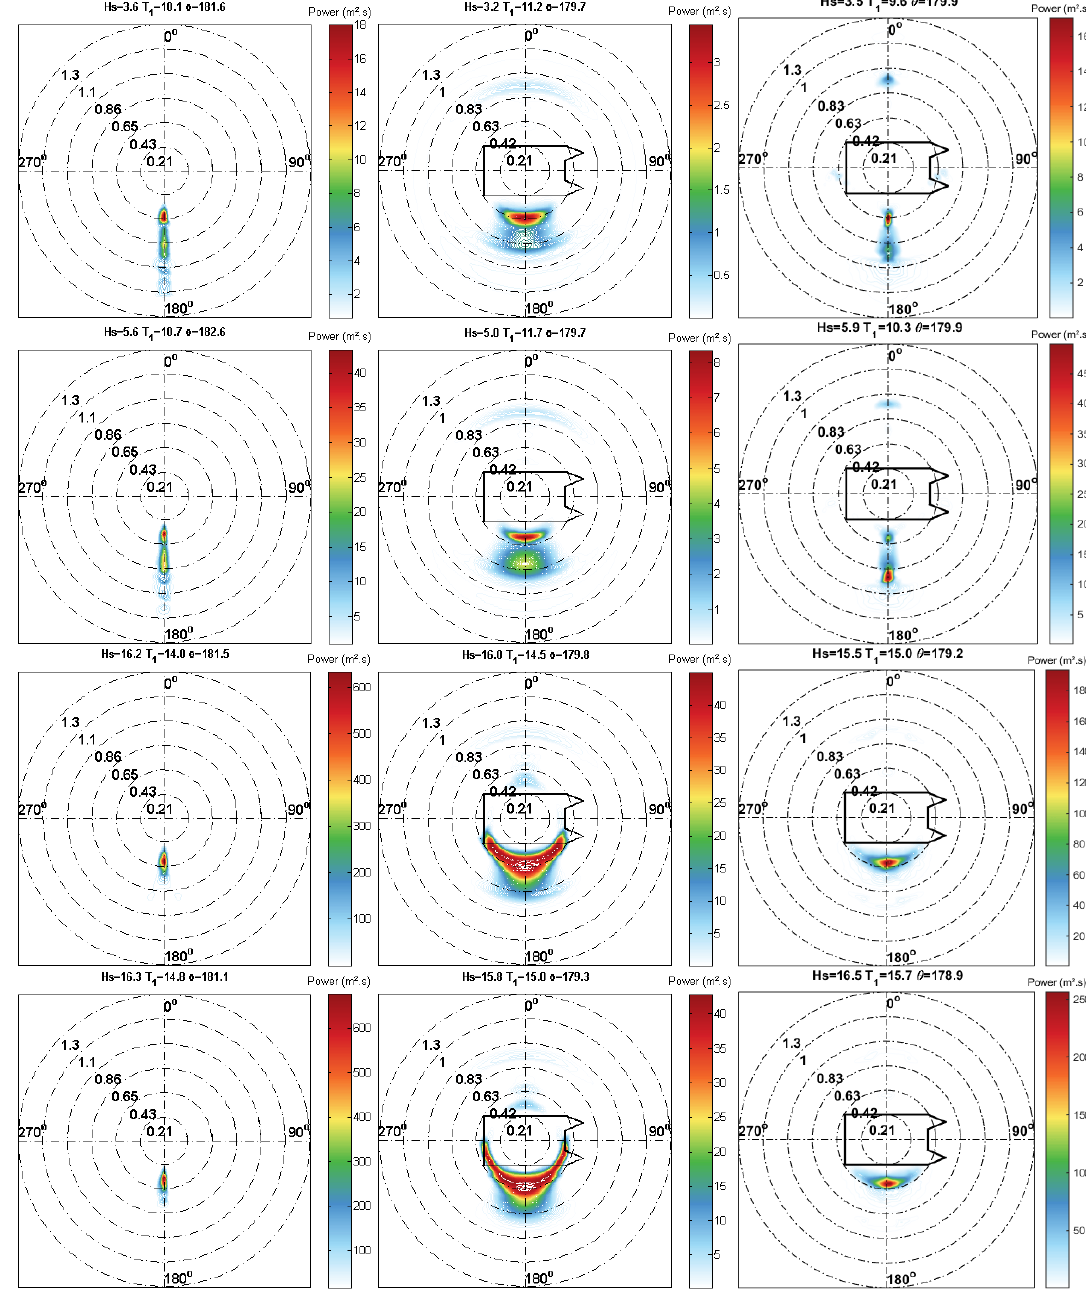
Figure 10. Comparison of directional wave spectra estimated with two different methods (for a heading equal to 90 deg.) and the paradigm. From left-to-right: Measured sea spectrum (MEM), the ones estimated with the conventional prior distribution and the output obtained with the alternative approach. From top-to-bottom: Sea conditions as provided Table